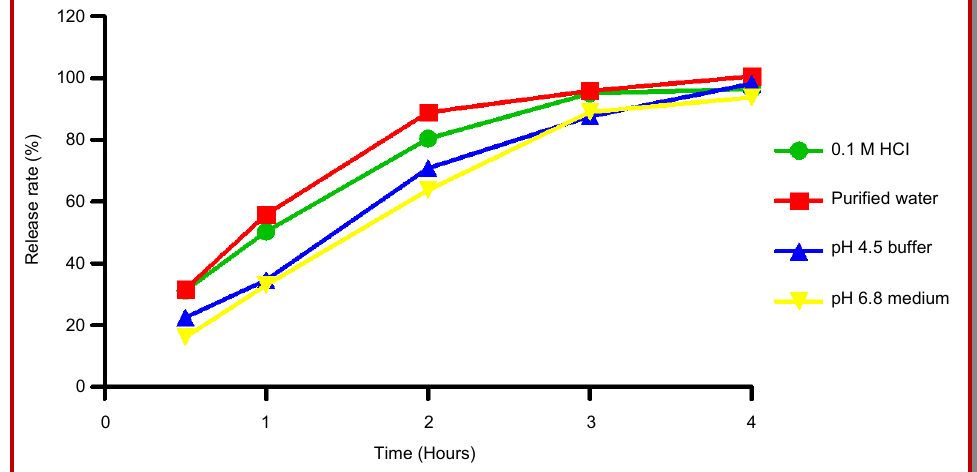
Figure 2: Effects of different mediums on the release of minocycline hydrochloride in marketed product. Each point represents average ± standard deviation (n = 6)